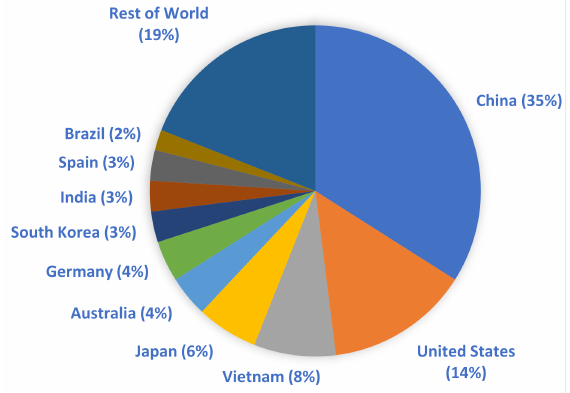
Figure 3. Share of installed PV solar panels in 2020. Source: Own elaboration based on